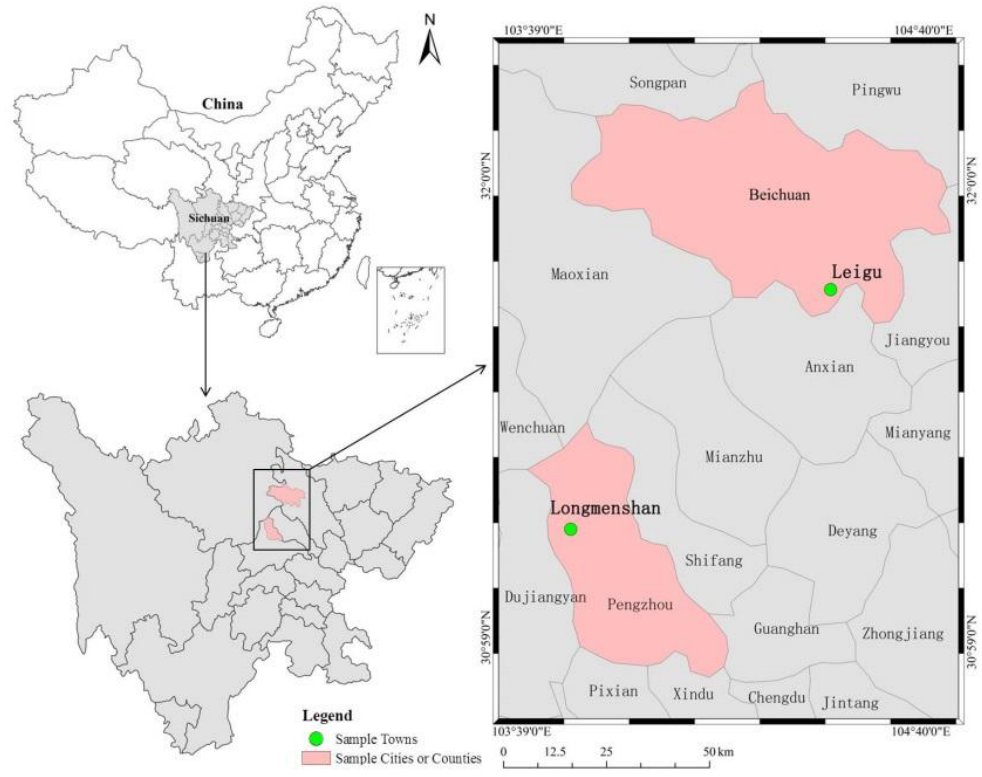
Figure 1. Locations of sample counties (cities) and sample towns.